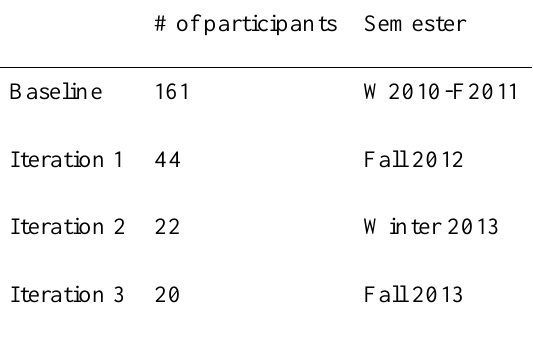
Breakdown of Participants by Iteration # of participants Semester Baseline